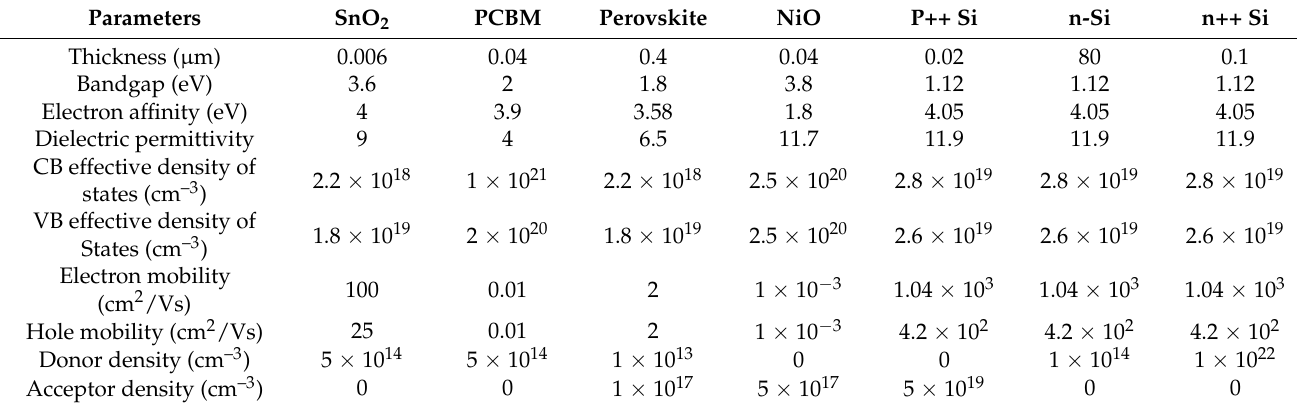
Table 1. Basic electrical properties of the materials used in the proposed structure